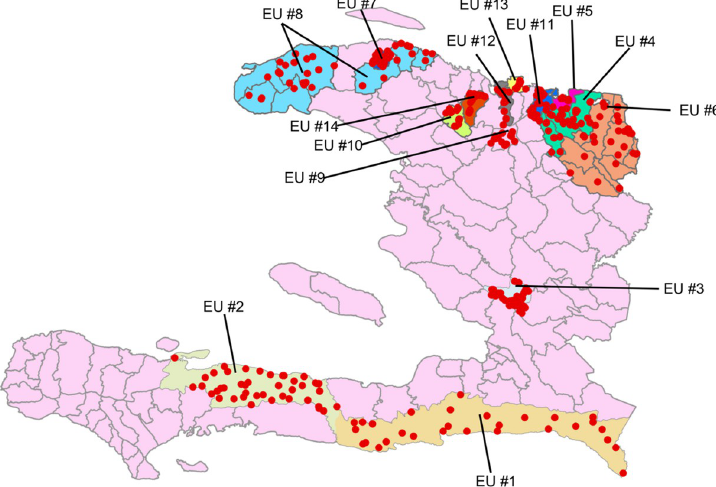
Fig 1. Sites of Transmission Assessment Surveys and Evaluation Units. Red circles represent schools where schoolchildren in grades 1 and 2 were tested. The administrative division shapefile that served as a base map is available at https://data.humdata.org/dataset/777e8b06-337f-4295-80bc-ca1515244215/resource/9b57a285-e12f-4d1a- b167-676d96a2b4af/download/hti_adm_cnigs_20181129.zip; the shapefile with Evaluation Unit number as an attribute is available for download at https://doi.org/10.15139/S3/JUUSHC.